Question: Which kind of chart has been used to present this data?
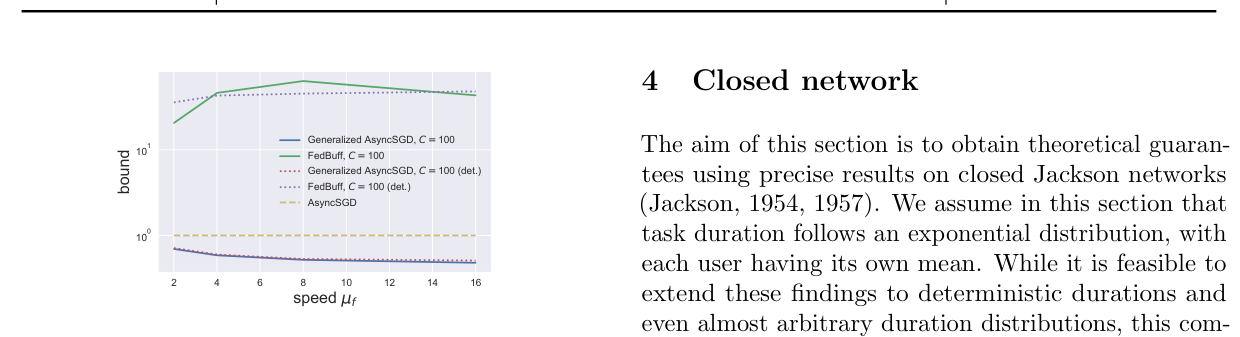
Answer: line